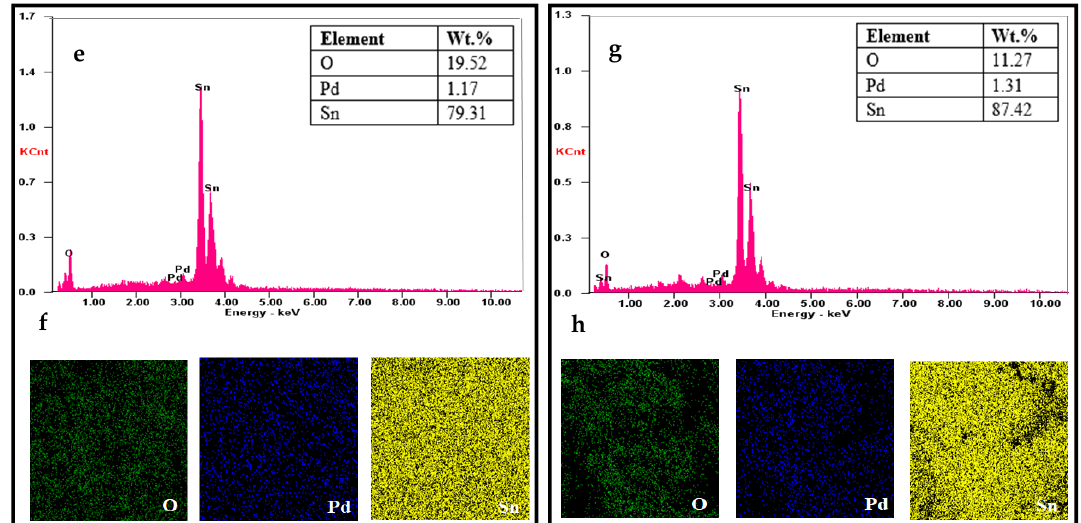
Figure 7. Energy-dispersive X-ray elemental mapping analysis. ( a ) EDX spectrum of SnO 2 . ( b ) EDX mapping of elements O and Sn in SnO 2 . ( c ) EDX spectrum of SnO 2 with 0.1% Pd. ( d ) EDX mapping of elements O, Pd, and Sn in SnO 2 with 0.1% Pd. ( e ) EDX spectrum of SnO 2 with 0.2% Pd. ( f ) EDX mapping of elements O, Pd, and Sn in SnO 2 with 0.2% Pd. ( g ) EDX spectrum of SnO 2 with 0.3% Pd. ( h ) EDX mapping of elements O, Pd, and Sn in SnO 2 with 0.3% Pd.